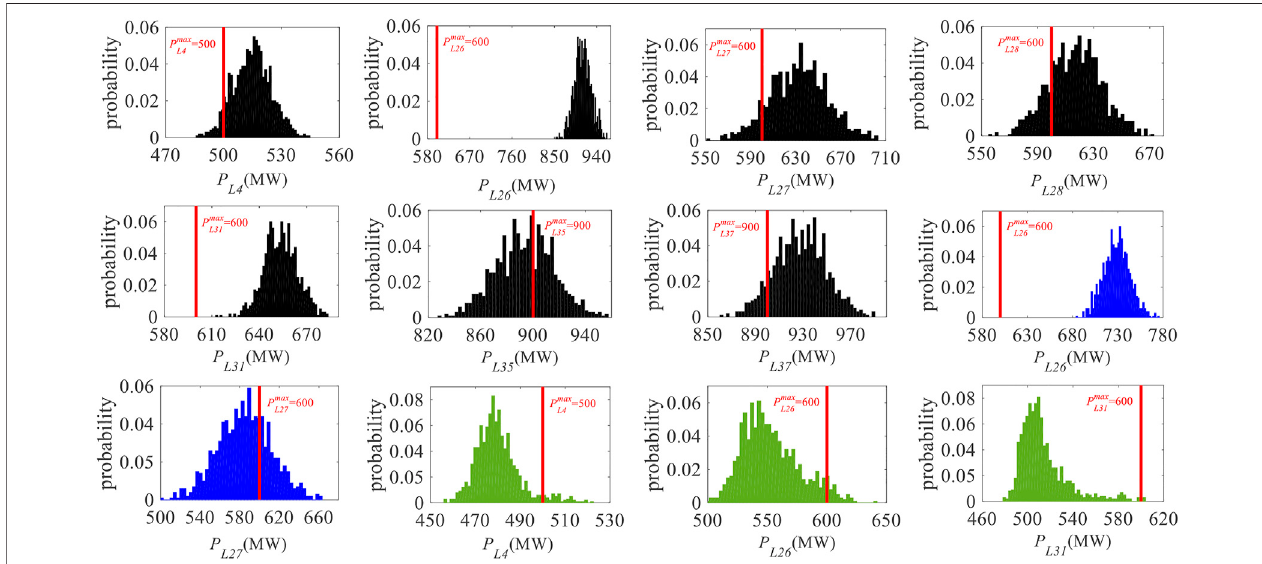
FIGURE 7 | Active power distributions of overload branches for contingency 26 using different methods.